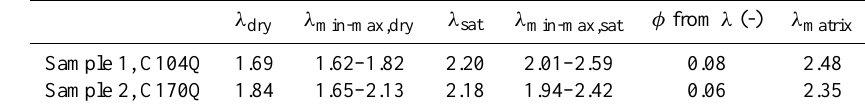
Table 2. Summary of the different measured thermal conductivity values λ (Wm − 1 K − 1 ) for the two samples from unit 3 (breccia) and unit 4 (fractured bedrock), respectively, minimum (min) and maximum (max) values along the scanning line, as well as mean values. Porosity φ and matrix thermal conductivity λ matrix are determined from saturated λ sat and dry thermal conductivity λ dry measurements.